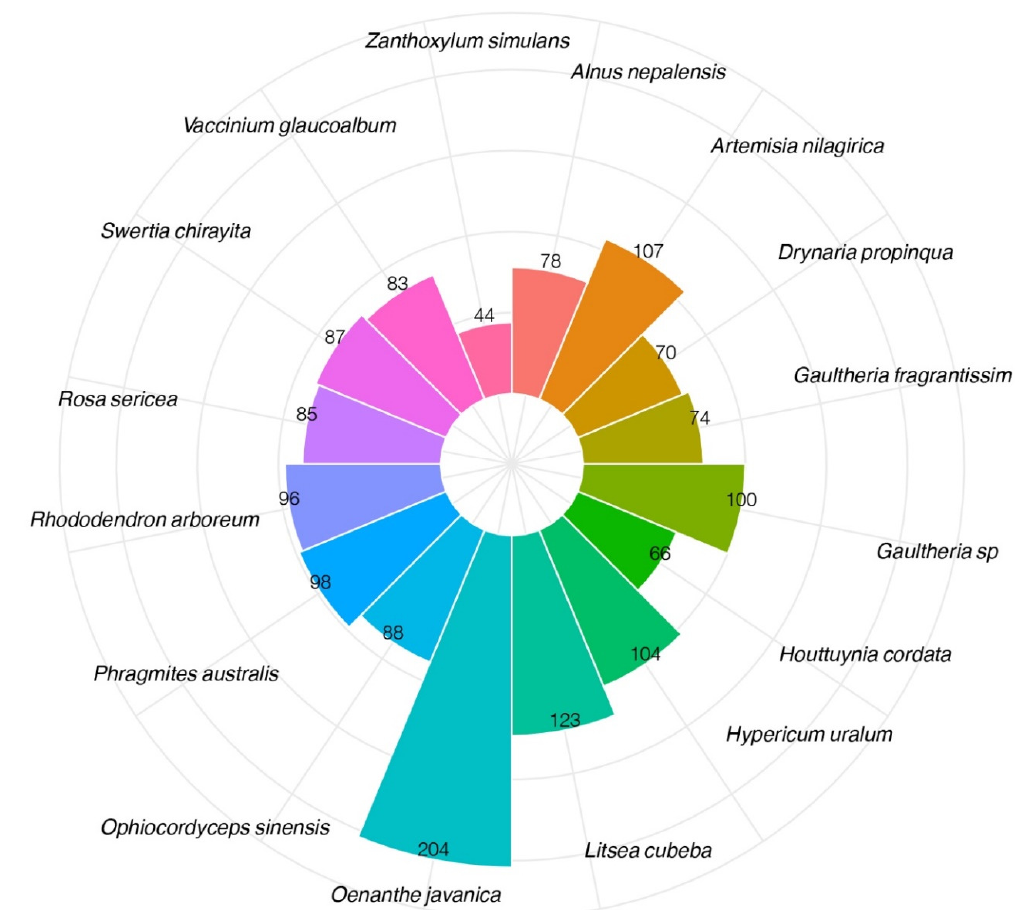
Figure 8. Radial bar plot of URs (Use Reports): O. javanica r ecorded with the highest use reports among the medicinal plants used by the Monpas of Dirang, Arunachal